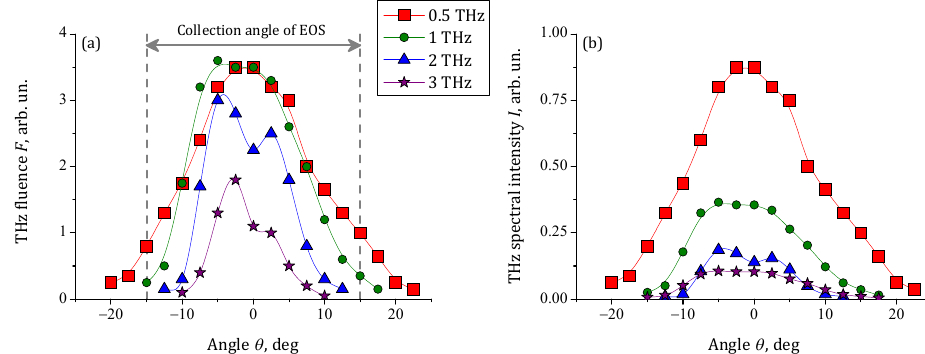
Figure 3. Angular distributions of ( a ) THz fluence F ( θ ) measured by the Golay cell with bandpass filters at the frequencies ν = 0.5 THz (red squares), 1 THz (green circles), 2 THz (blue triangles), 3 THz (violet stars) and ( b ) THz spectral intensity I ( θ ) obtained from ( a ) by the correction to the maximal transmittance of the filters T and their bandwidth ∆ ν , see Equation (2).